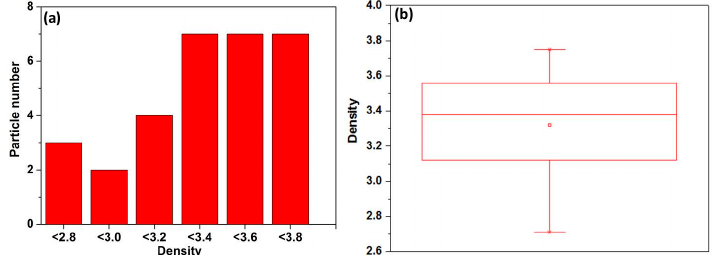
Figure 2. Density distribution of 30 particles ranging from 31.5 to 26.5 mm. ( a ) Particle number as a function of density; ( b ) Statistic analysis of the density.